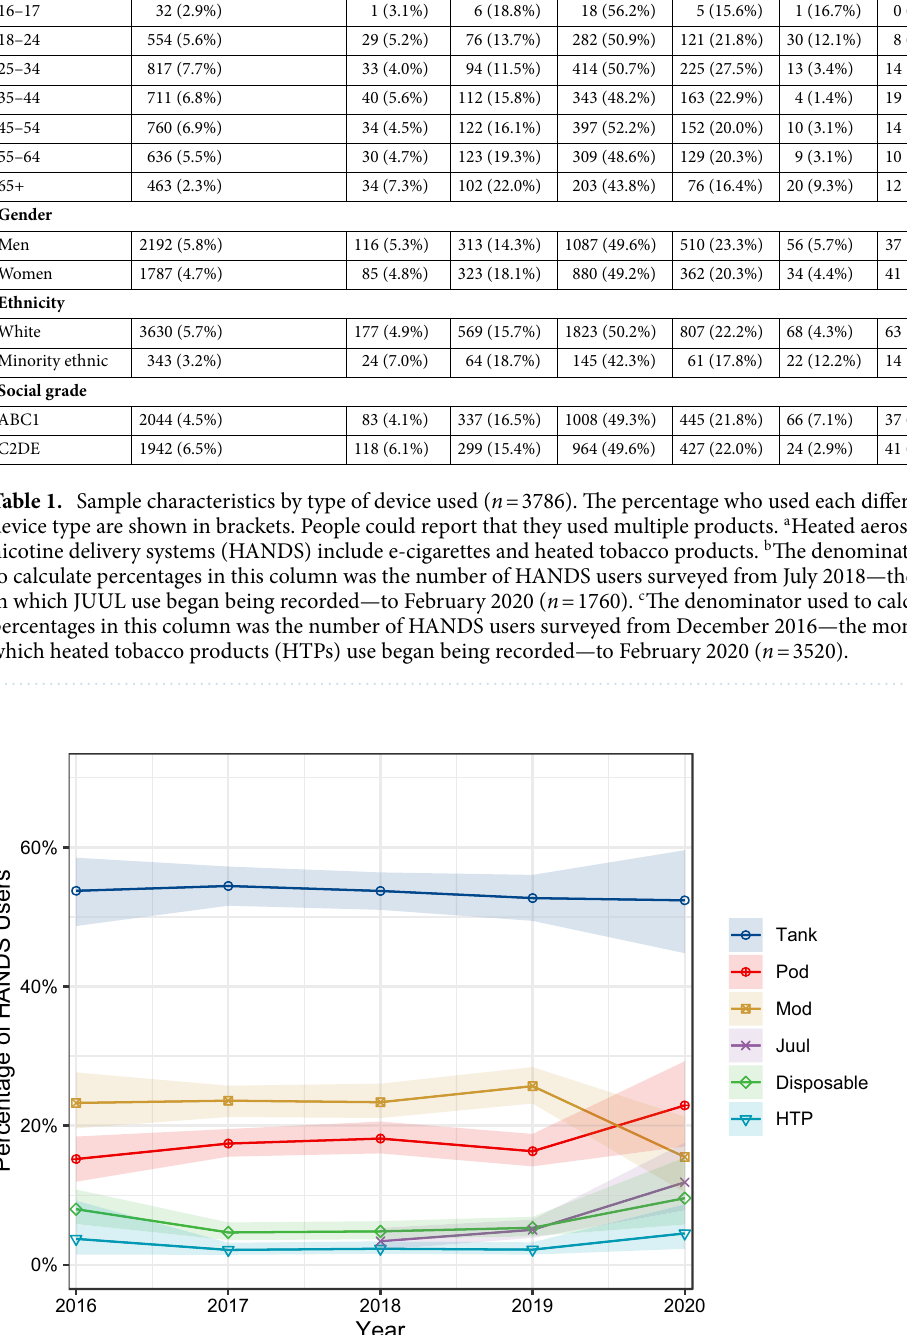
Figure 1. Use of different e-cigarette device types and heated tobacco product use among adult heated aerosolized nicotine delivery system (HANDS) users in England from 2016 to 2020. Shaded bands represent 95% CrIs. Trends would be the same with a denominator of all adults rather than only HANDS users, as overall prevalence of HANDS use was stable from 2016 to 2020 (Supplementary Fig. S2). Some people reported using JUUL but not pods. When these individuals were considered pod users, there was a more pronounced rise in pod use from 19.5% in 2019 to 30.4% in